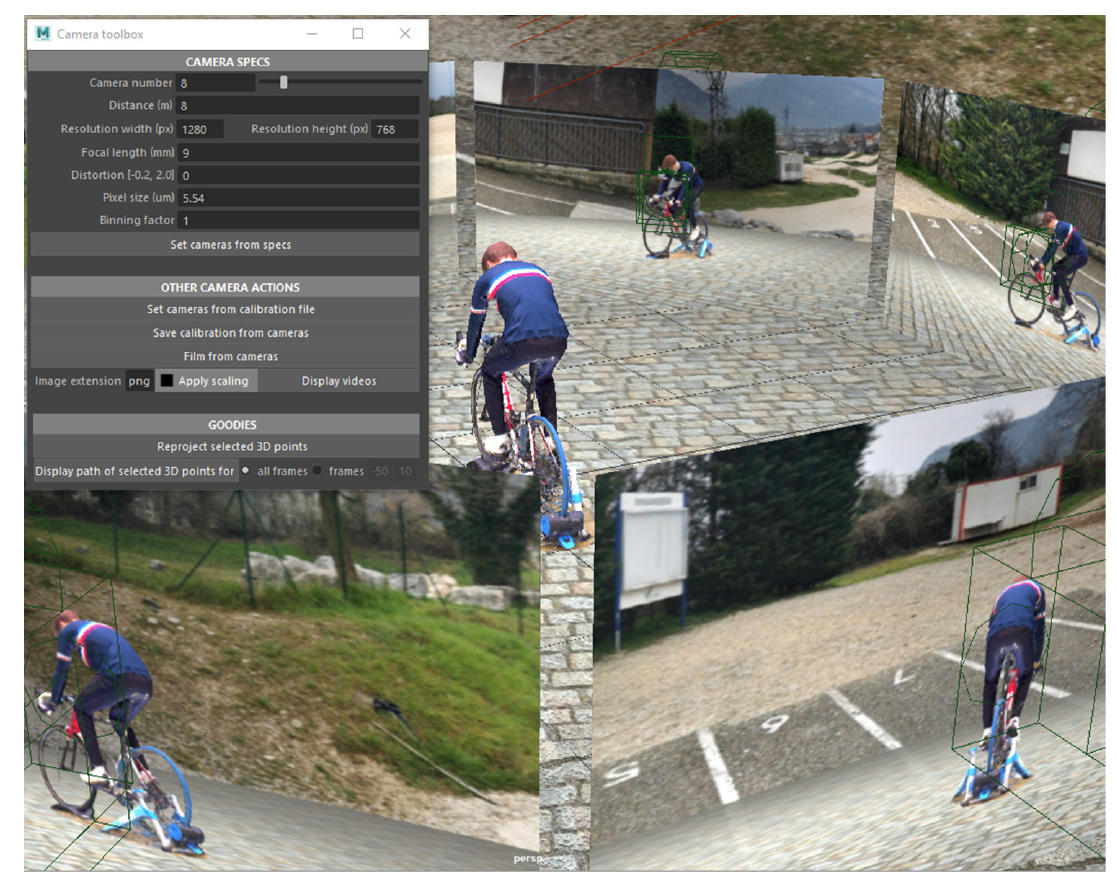
Figure 3. The camera toolbox developed for Autodesk Maya, which lets one set up virtual cameras, save their parameters in a calibration file, and film realistic looking synthetic videos. Here, we set up 8 video cameras, regularly distributed 8 m away from the subject.